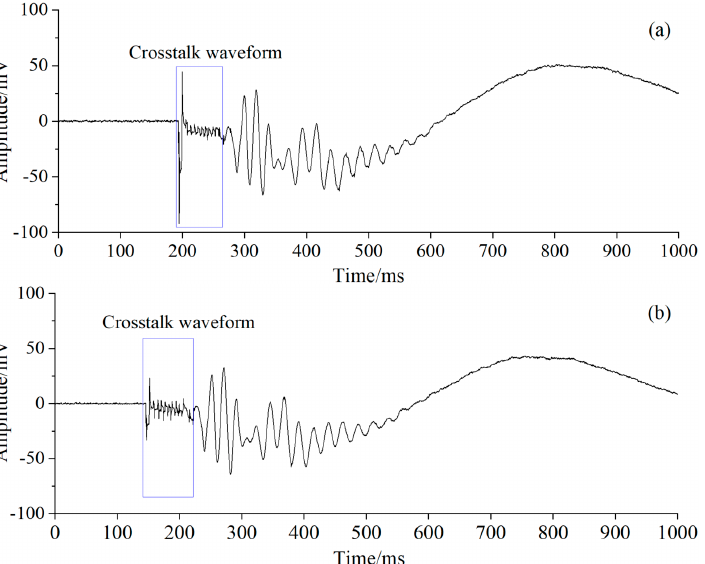
Figure 11. The time-domain waveform of AE by the PLB method: ( a ) Lead-breaking position is 50 mm; ( b ) lead-breaking position is 150 mm.